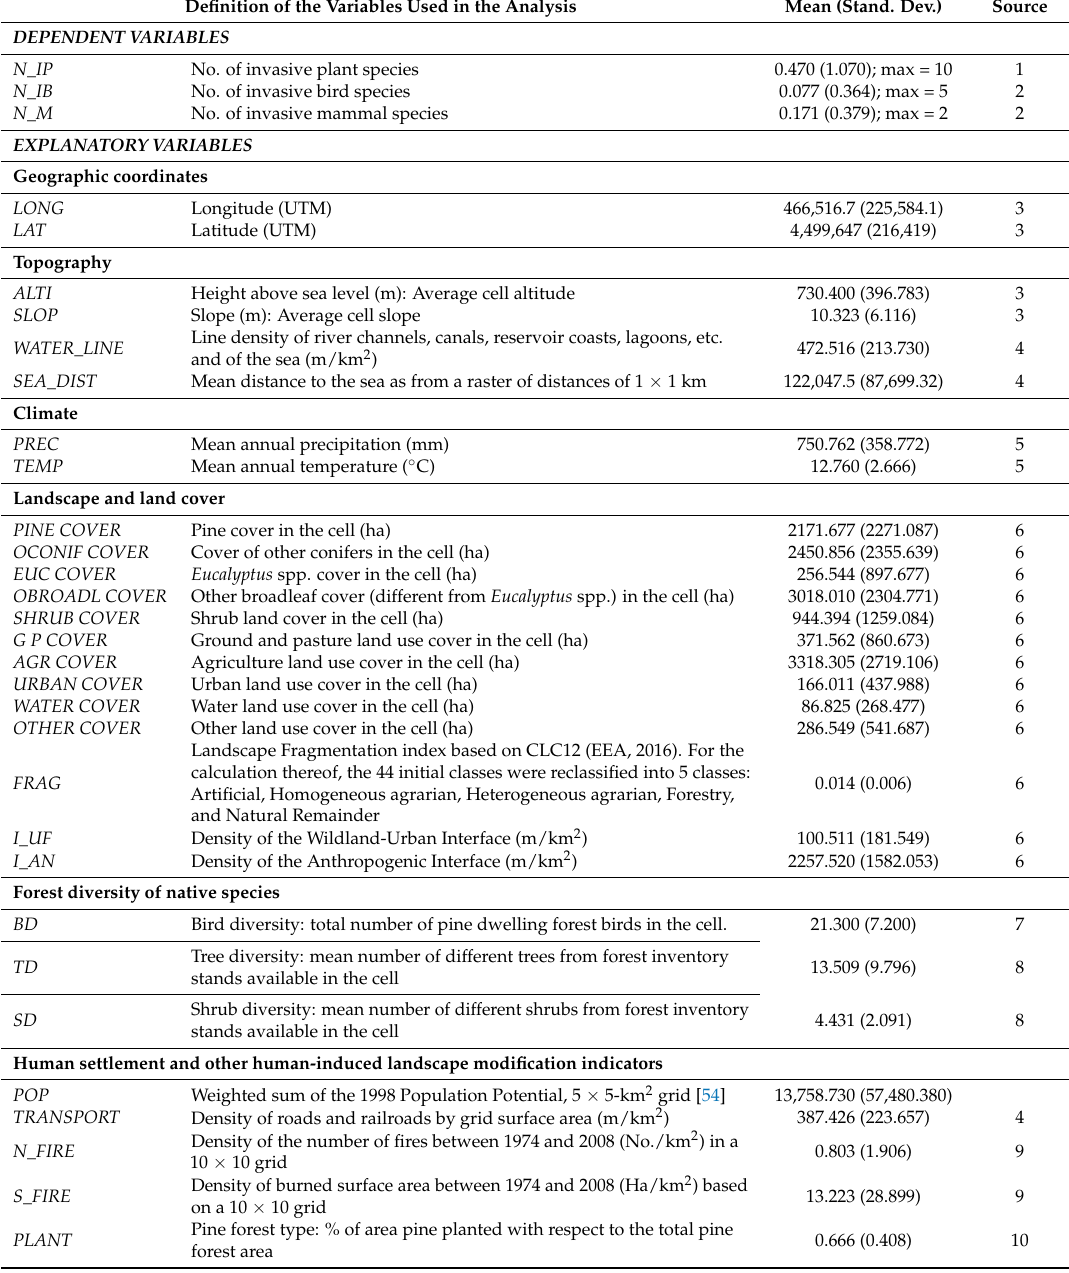
Table 2. Description of the variables used in the analysis ( N = 3950 10 × 10 UTM cells). Definition of the Variables Used in the